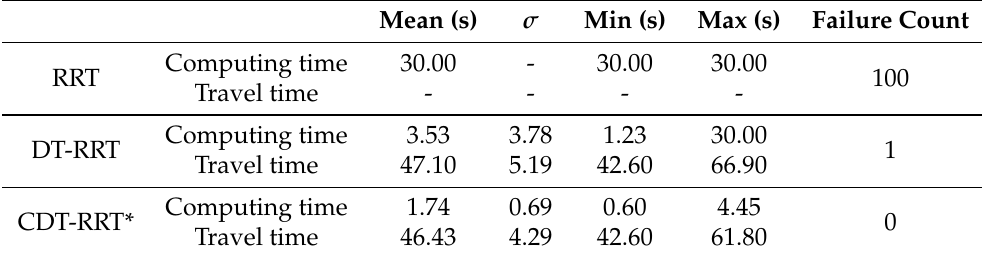
Figure 16. Histogram of the computing time for the results from simulation 7. Table 8. Summary of Planning Results from simulation